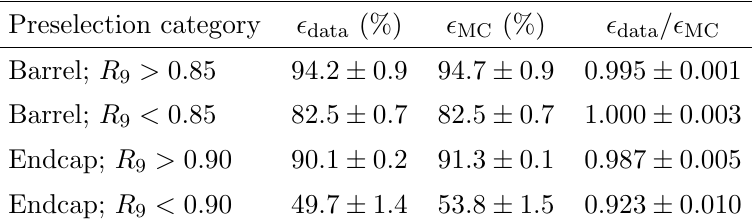
Table 2 . Photon preselection e(cid:14)ciencies as measured in four photon categories, obtained with tag- and-probe techniques using Z ! e + e (cid:0) and Z ! (cid:22) + (cid:22) (cid:0) (cid:13) events. The quoted uncertainties include the statistical and systematic